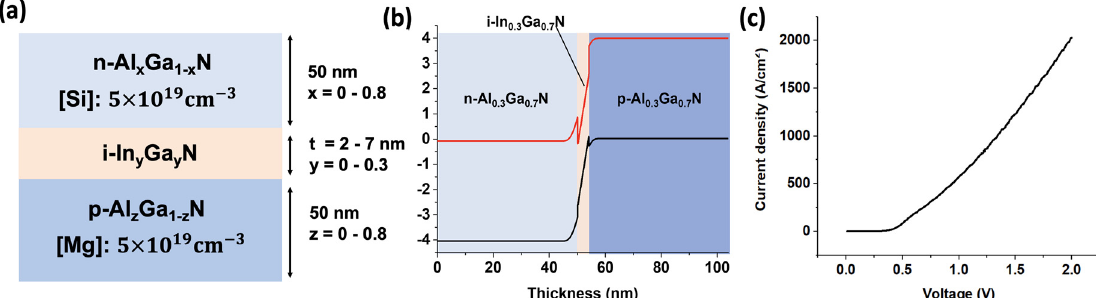
Figure 1. ( a ) Cross-sectional schematics of the proposed p-Al x Ga 1-x N/i-In y Ga 1-y N/n-Al z Ga 1-z N TJ structures. ( b ) An example of the p-Al 0.3 Ga 0.7 N/i-In 0.3 Ga 0.7 N/n-Al 0.3 Ga 0.7 N TJ band structure. ( c ) Calculated current–voltage curve for the p-Al 0.3 Ga 0.7 N/i-In 0.3 Ga 0.7 N/n-Al 0.3 Ga 0.7 N tunnel